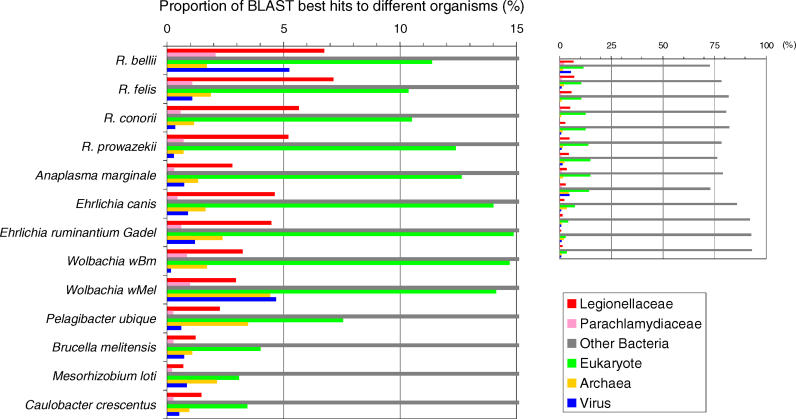
Proportions of BLAST Best Hits to Different Organism GroupsThe percentages are given relative to the total number of ORFs exhibiting database hits (E-value < 10−5).